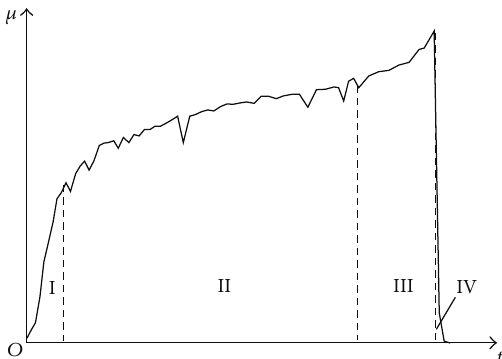
Figure 2: Typical curve of the instant friction coefficient during emergency braking.